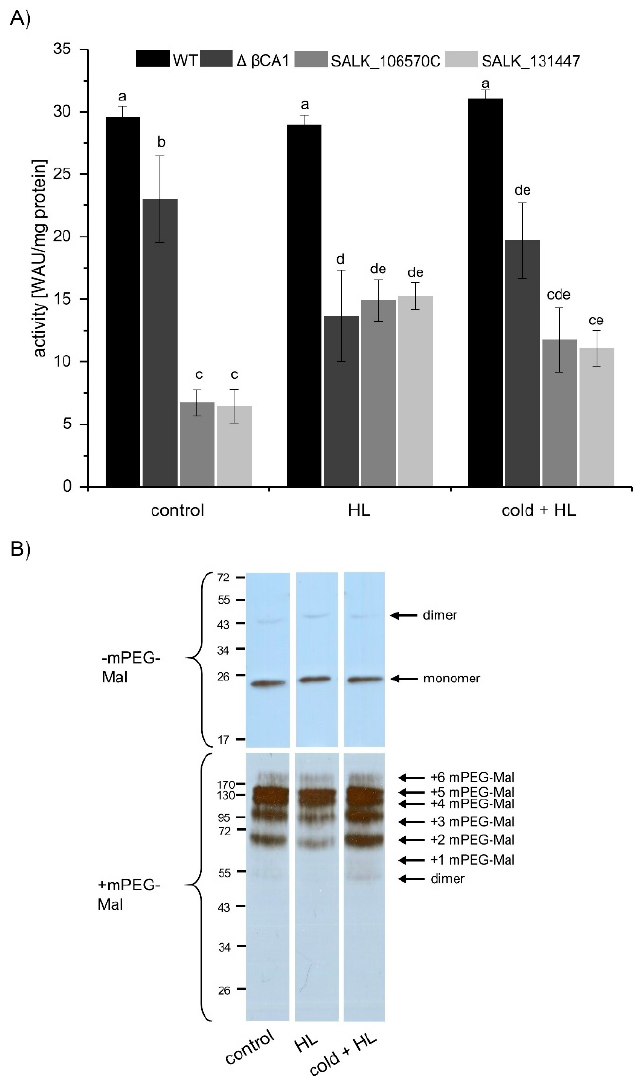
Figure 5. Effect of high light (HL) or combined HL and cold on CA activity. ( A ) CA activity in extracts of WT, SALK_106570C, and SALK_131447 plants treated with HL or cold together with HL for 1 h. Δβ CA1 activity was calculated as difference between the WT CA activity and the mean activity of the two β ca1 knock out lines from the corresponding treatment. Data represent the mean ± SE of n ≥ 8 from three independent experiments. Significant di ff erences of p ≤ 0.05 are indicated by di ff erent letters a-e. Significance of di ff erence was calculated using one-way ANOVA with post hoc Tukey HSD test. ( B ) Western blot with specific β CA1-antibody of treated WT plant material with and without mPEG-Mal labeling of free thiols.